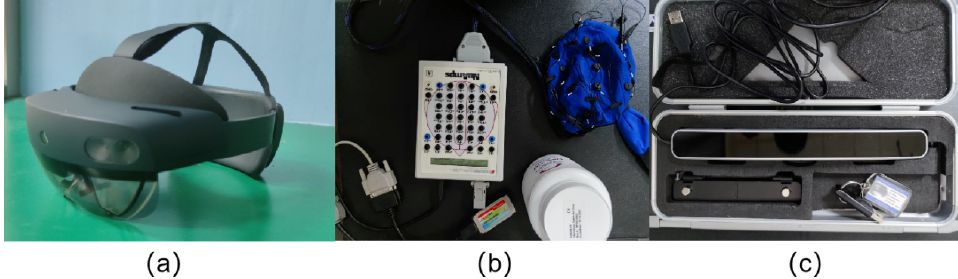
Figure 2. Experimental equipment. (( a ) Mixed reality display: HoloLens2; ( b ) Electroencephalograph; ( c ) Eye tracker).